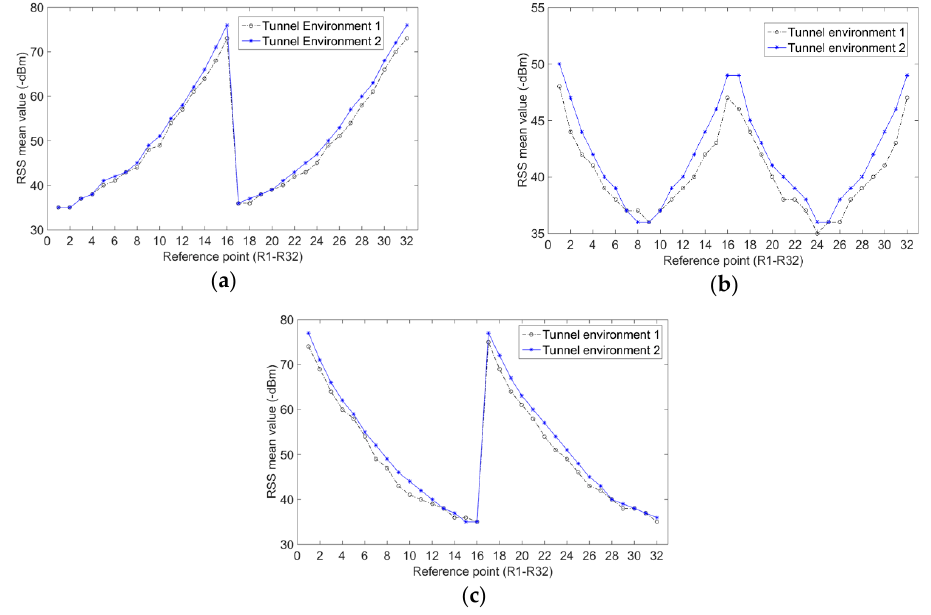
Figure 11. Received signal strength (RSS) mean value comparison of each reference point when tunnel environments changed: ( a ) mean value of AP 1 ; ( b ) mean value of AP 2 ; ( c ) mean value of AP 3